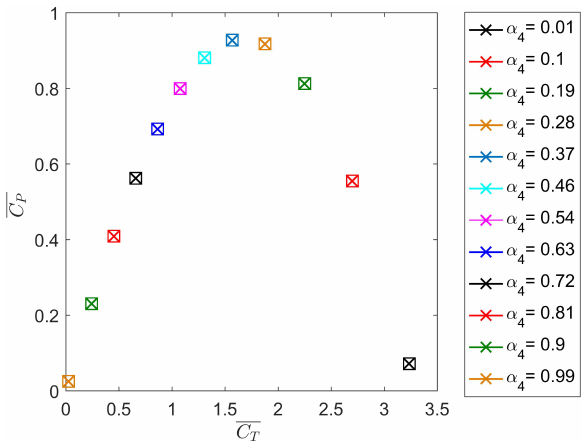
Figure 4. Time-averaged thrust and power coefficients obtained from a plausible range of the wake-induction factor, ADI (x marker), and TVD (square